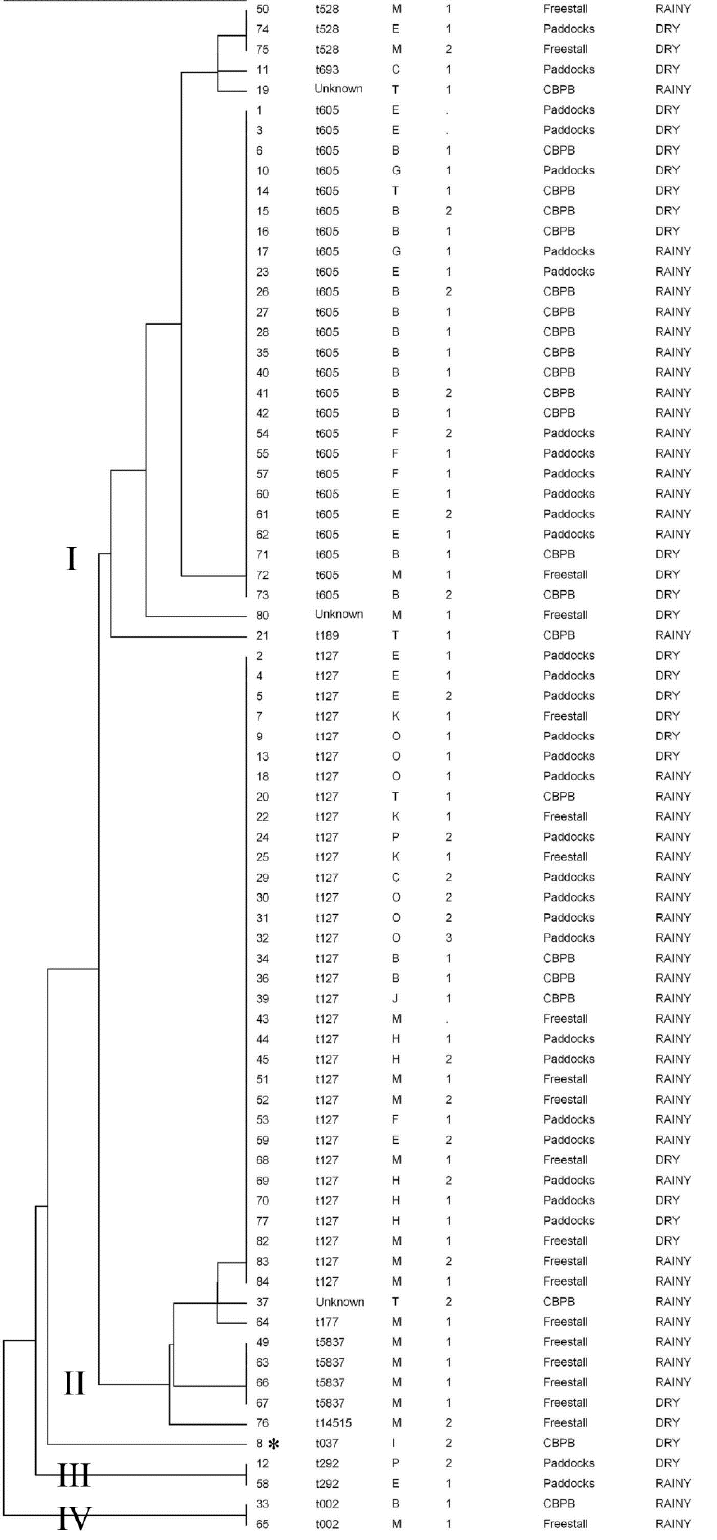
Figure 1. Clusters of spa-typing profiles of 76 Staph. aureus recovered from affected mammary quarters of cows with clinical mastitis in 13 dairy herds in Brazil. The data is presented according to the spa-typing classification, farm of origin, severity score of clinical mastitis, housing system used in the herd of origin, and season of clinical mastitis identification. For three isolates, the spa-type was unclassified (named here as “unknown”), and one isolate (* t 037) was not assigned to any